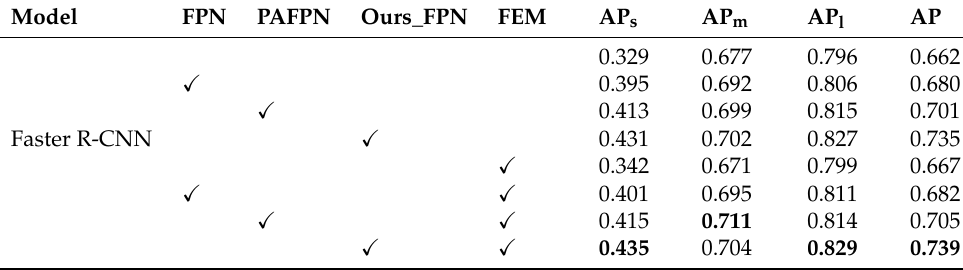
Table 3. Investigation of different modules introduced to the Faster R-CNN.